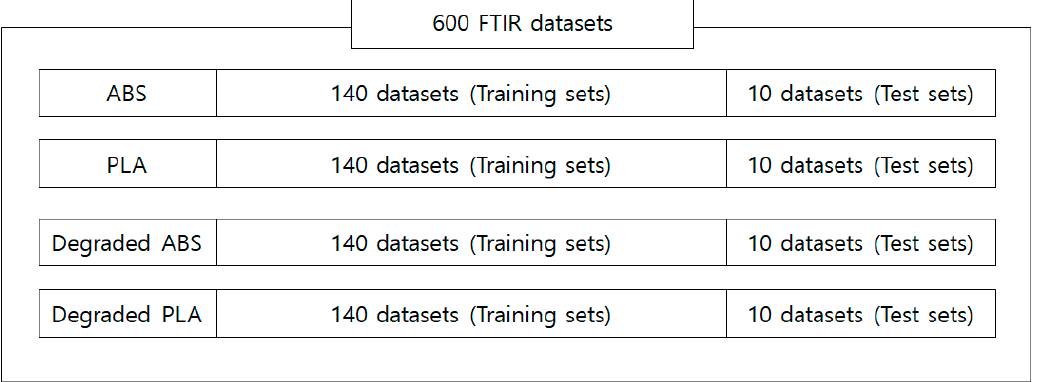
Figure 4. Description of FTIR datasets.